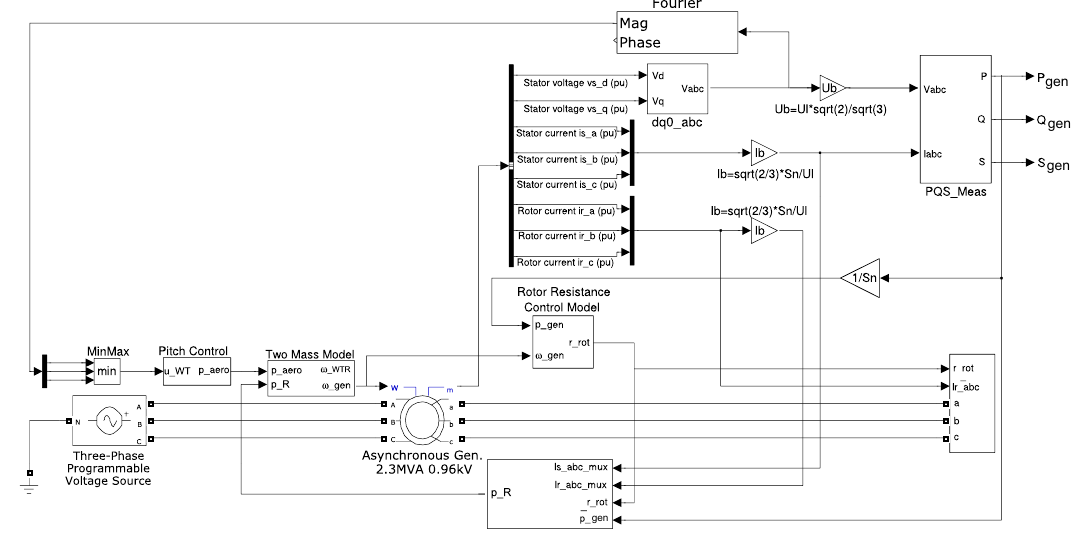
Figure 12. Type 2 WT